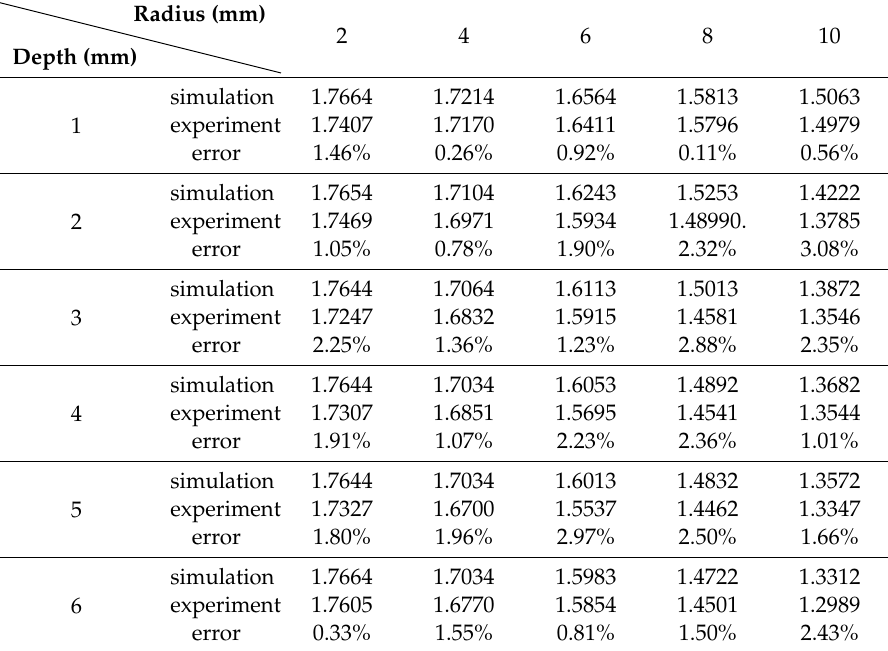
Table 10. Comparison of simulation data and experimentally obtained data of the volumetric corrosion